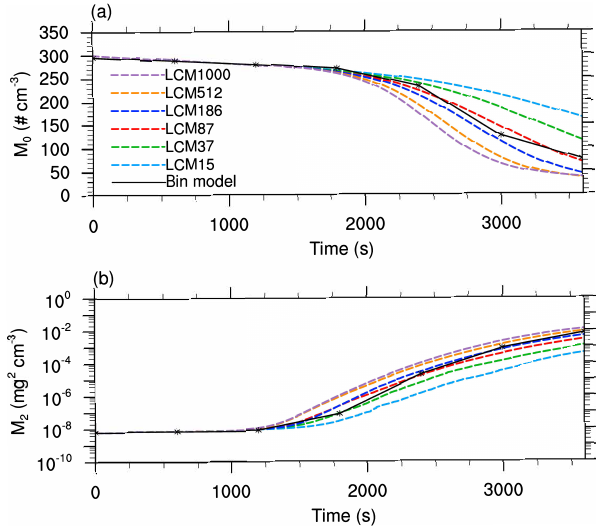
Figure 8. Same as Fig. 4 but for the multi-box approach, i.e., inter- actions between the grid boxes are possible.